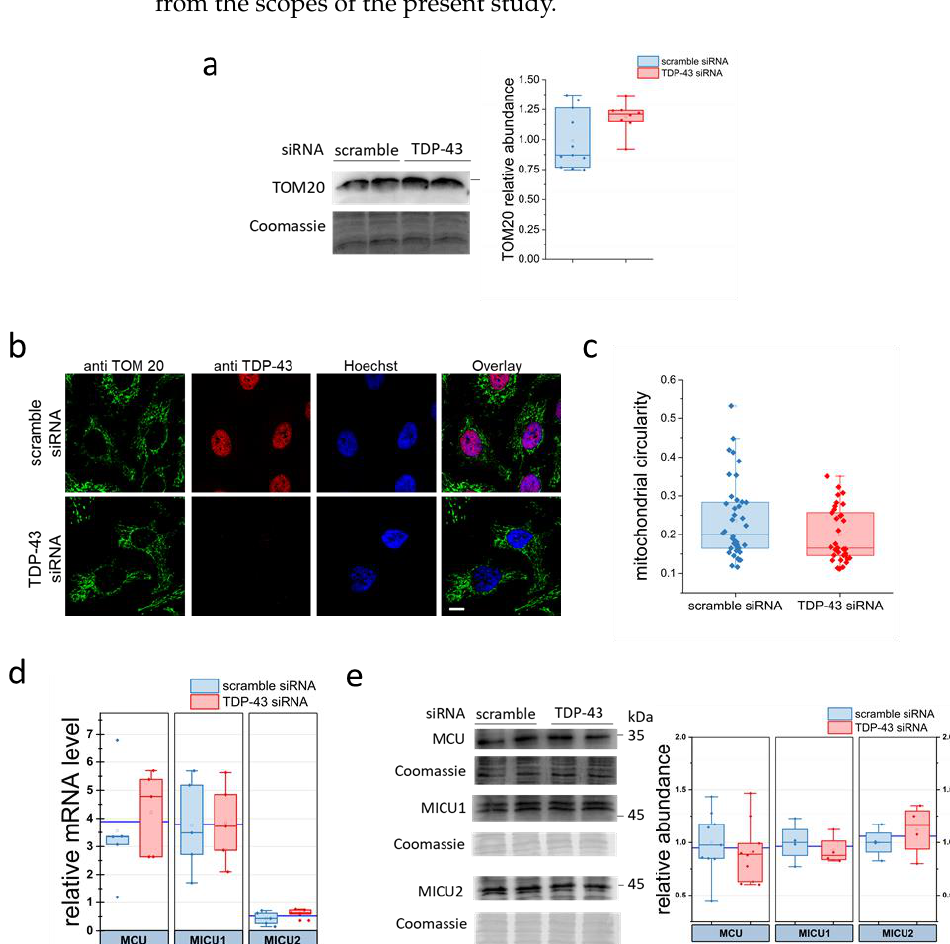
Figure 4. Mitochondria are unaffected by TDP-43 silencing in HeLa cells. ( a ) TOM20 expression was analysed by WB in lysates of HeLa cells silenced, or not (scramble), for TDP-43 expression. Both a representative WB (left panel) and the densitometric analysis for TOM20 expression (right panel) are reported; n = 8 for each cell type, p -value > 0.1. ( b ) Representative confocal images of TDP-43-silenced or control (scramble) HeLa cells stained with antibodies to TOM-20 and to TDP-43. Nuclei were visualised by Hoechst staining. Scale bar, 20 µm. ( c ) The box plot reports the values of mitochondrial circularity (see Materials and Methods) in both cell types. n = 41 cells for each condition, p -value > 0.06. ( d , e ) The relative abundance of MCU, MICU1 and MICU2 mRNAs ( d ) or proteins ( e ) were evaluated by RT-PCR or WB, respectively. In ( e ), representative WBs (left panel) and densitometric analyses of immunoreactive bands (right panel) are reported. n = 5, p -value > 0.5 ( d ); n = 4, p -value > 0.2 ( e ). Mann–Whitney U test for all statistics.